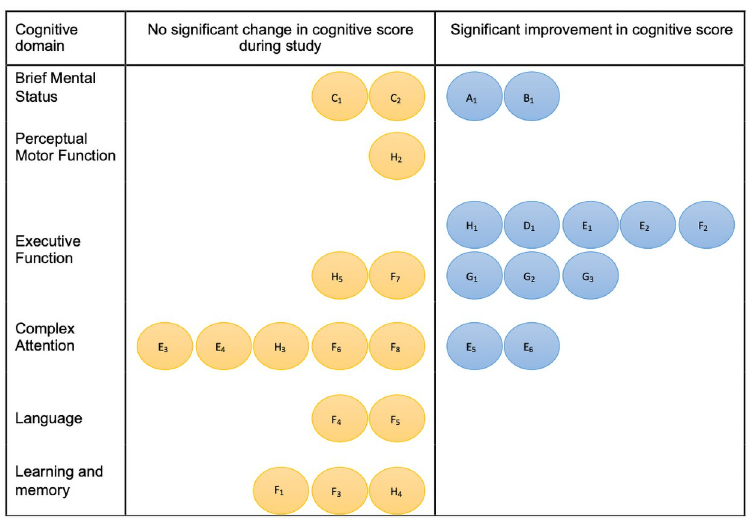
Fig 3. Representation of cognitive tests divided into cognitive domains for studies without control group. A: Acar 2011 (A1: MMSE); B: Magalh ã es 2011 (B1: MMSE); C: Boi 2012 (C1: MMSE, C2: CDT), D: Castiglione 2016 (D1: Digit Span Test); E: Desjardins 2016 (E1: Listening Span Test, E2: Reading Span Test, E3: Auditory reaction time, E4: Stroop test, E5: DSST, E6: Corpus response measure), F: Deal 2017 (F1: Delayed word recall, F2: Logical memory A, F3: Incidental learning, F4: Word fluency, F5: Boston naming test, F6: Trail making test A, F7: Trail making test B, F8: DSST); G: Maharani 2018: (G1: immediate and delayed word recall, G2: Serial 7’s, G3: date naming); H: Sarant 2020 (H 1: GML test, H2: Detection test, H3: Identification test, H4: One card learning test, H5: One back